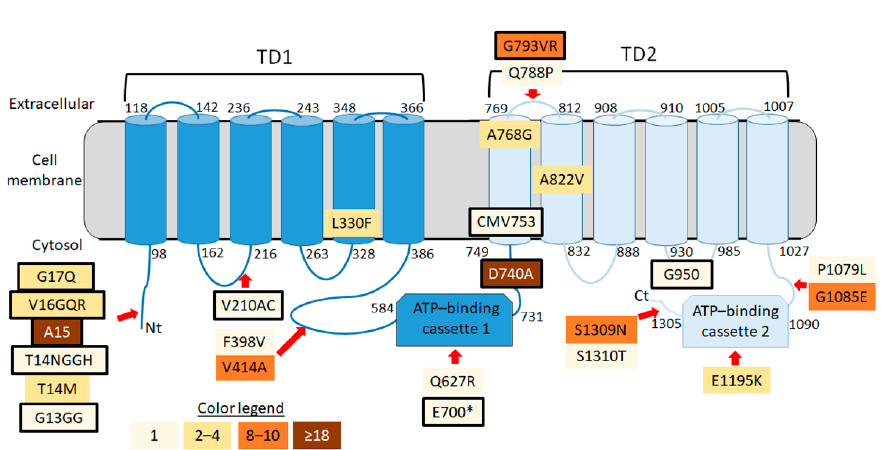
Figure 2. Schematic representation (not drawn to scale) of SfABCC2 topology on the cell membrane and location of detected nonsynonymous, nonsense and frameshift mutations in sequenced S. frugiperda samples from Puerto Rico. Amino acid numbers are indicated at the start and end of transmembrane domains and ATP-binding cassettes as predicted based on detection of conserved domains in BLAST searches. Distinct colors in boxes indicate the number of individuals carrying each mutation, as detailed in the color legend. The only nonsense mutation (E700 *) and all frameshift mutations are shown in a boxes with bold borders, including the SfABCC2mut allele (D740A). TD = transmembrane domain.